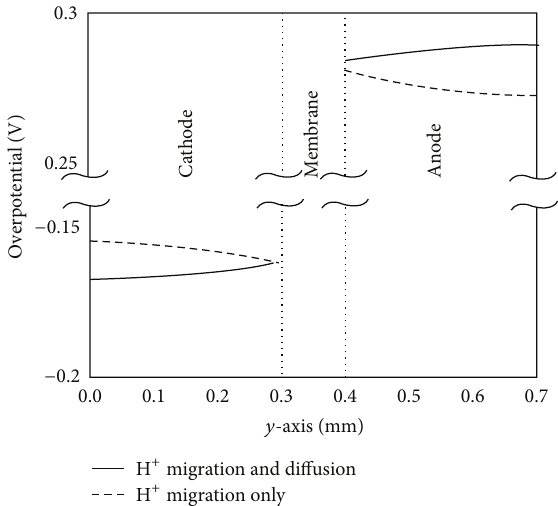
Figure 8: Overpotential profile in the anode and cathode along 𝑦 - axis at the middle of the modeling domain. Solid lines (migration plus diffusion). Dashed lines (migration only)